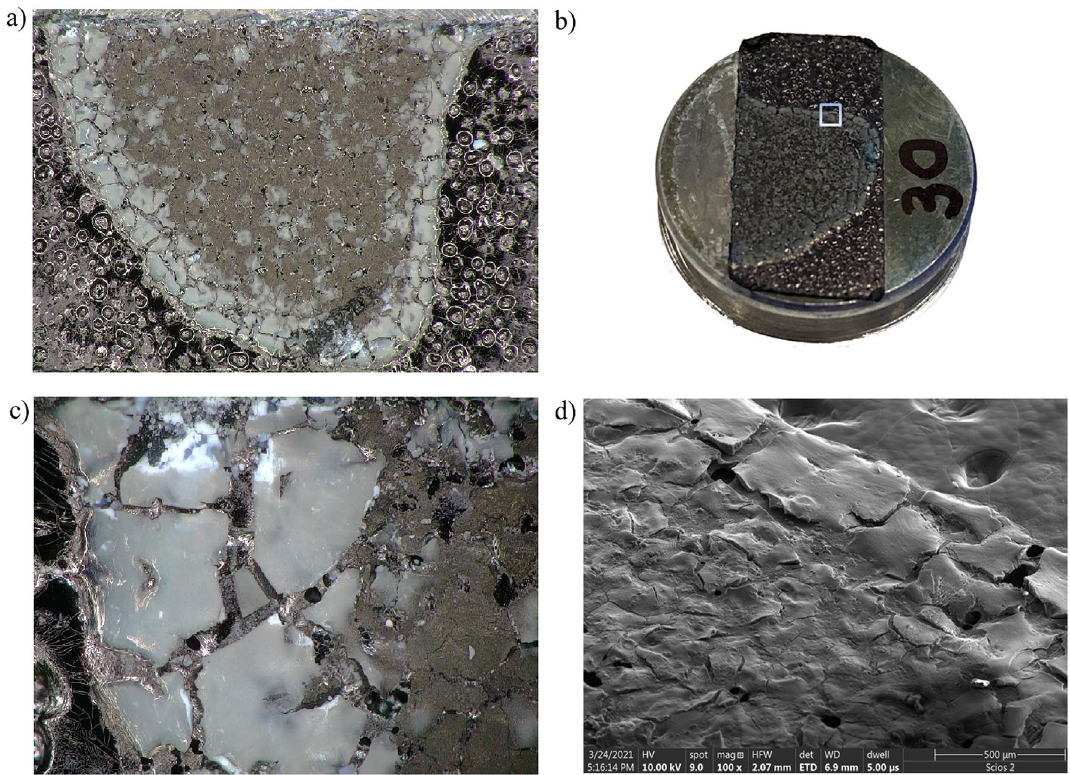
Figure 3. Photos of sample B : ( a ) image from optical microscopy; ( b ) macro image of the pin; ( c ) image from optical microscopy of the marked area; ( d ) SEM images of the edge of the sample—powder particles were found both on the edge and inside.